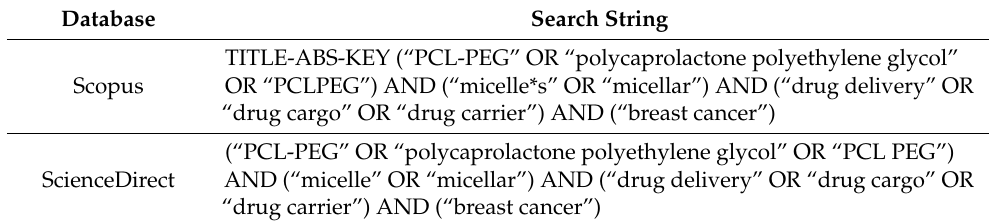
Table 1. The search strings.